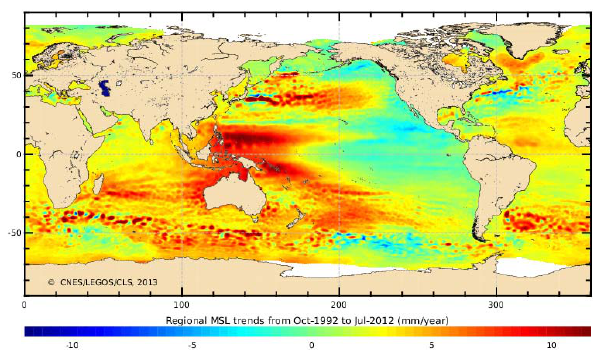
Fig. 4. Regional variations of mean sea level variations over the 1992–2012 time period (in mmyr − 1 ). This map is obtained us- ing multi-mission SSALTO/DUACS gridded fields, which enable the local slopes to be estimated with a high resolution. (Credits